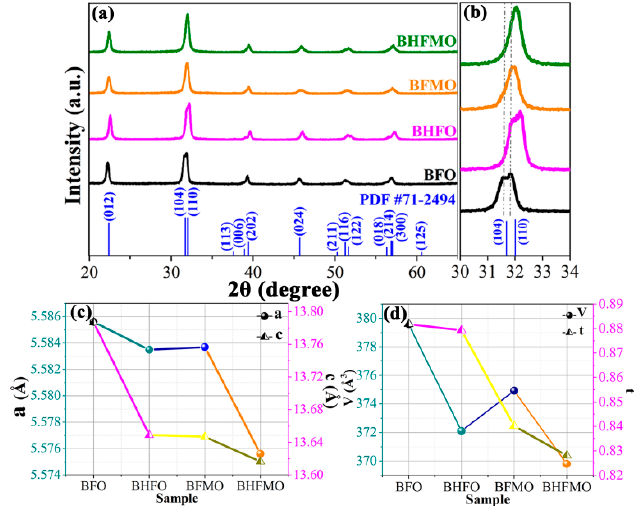
( a ) X-ray diffraction (XRD) patterns of BiFeO 3 (BFO), Bi 0.95 Ho 0.05 FeO 3 (BHFO), BiFe 0.95 Mn 0.05 O 3 (BFMO) and Bi 0.95 Ho 0.05 Fe 0.95 Mn 0.05 O 3 (BHFMO) thin films; ( b ) The magnified patterns of the diffraction peaks located at around 32 ◦ ; ( c , d ) calculated lattice parameters ( a , c ), cell volumes (V) and tolerance factors (t) as a function of all samples.